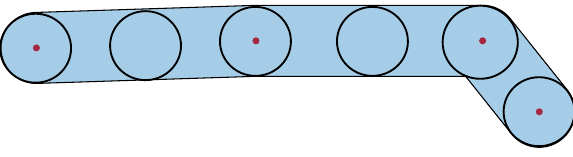
Figure 6. Creating the trajectory buffer.